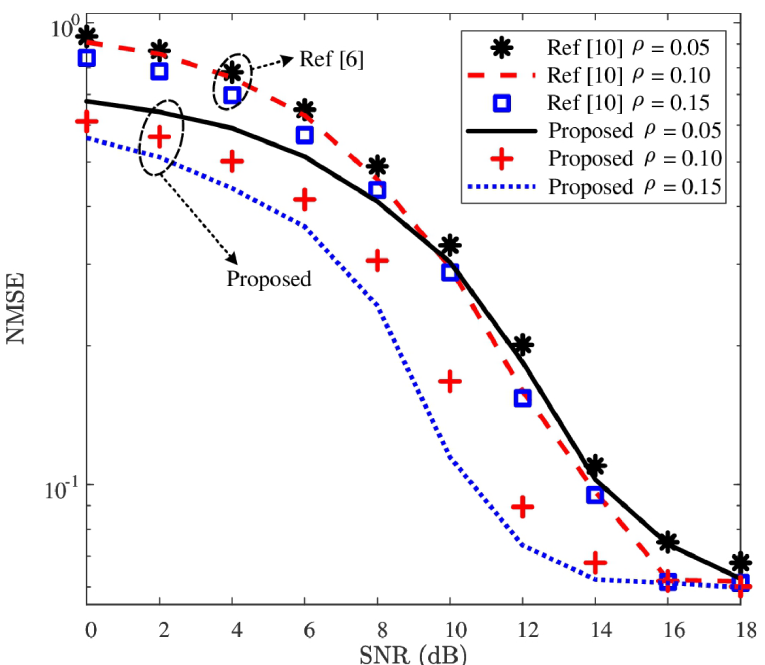
Fig 9. NMSE versus SNR, where P = 512 and c = 2.0 are considered, and the β of Ref [10] is 10.